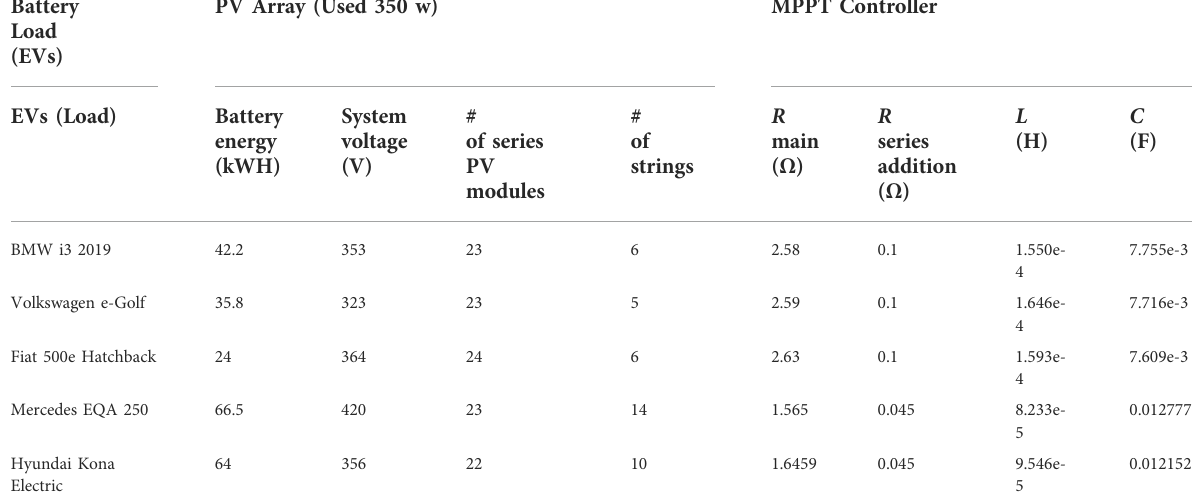
TABLE 4 Main parameters of MATLAB